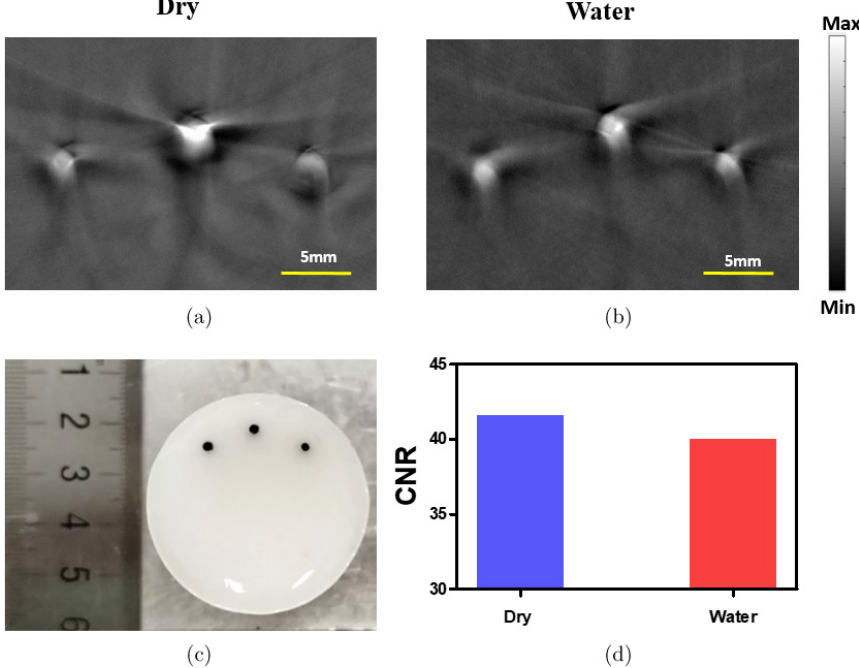
Fig. 3. PAT images of three 1 mm ink mixer objects with dry coupling (a) and water coupling (b). (c) The photograph of the phantom. (d) CNR of the images shown in (a) and